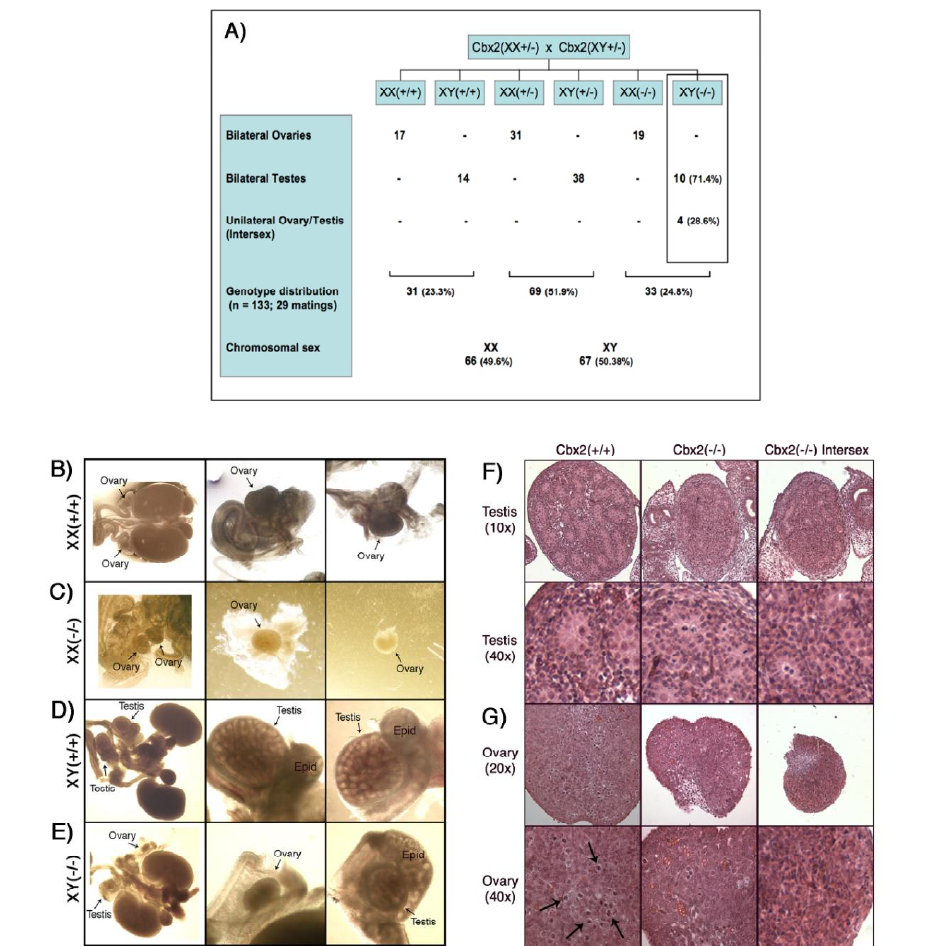
Figure 1. Targeted deletion of Cbx2 leads to sex reversal and gonadal